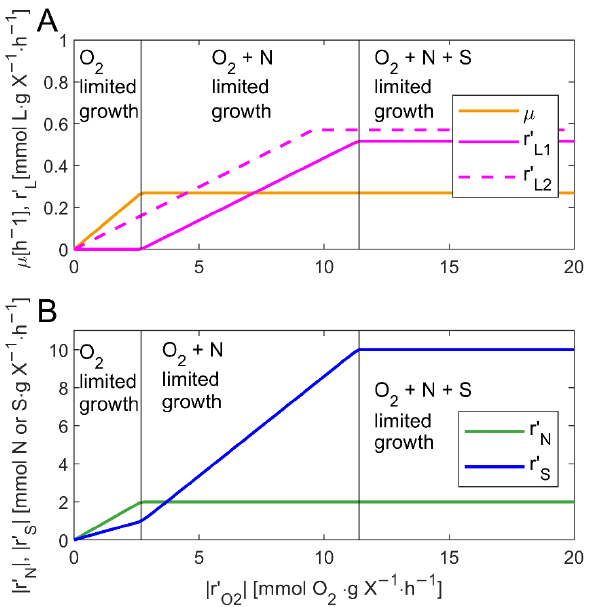
Figure 1. Effect of the specific oxygen uptake rate | 𝑟 𝑂2′ | on ( A ) the specific growth rate ( µ ) and the specific rate of lipid synthesis ( 𝑟 𝐿′ ; r ’ L1 is the maximum value of 𝑟 𝐿′ after µ was maximized, and r ’ L2 is the maximum value of 𝑟 𝐿′ when the flux through the biomass equation was set to zero) and ( B ) the specific consumption rate of glutamate | 𝑟 𝑁′ | and glucose | 𝑟 𝑆′ |.